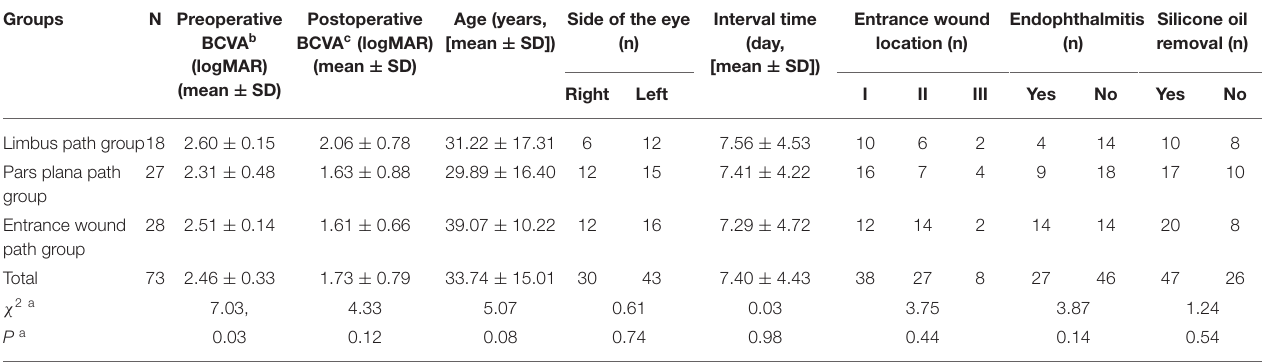
Groups N Preoperative